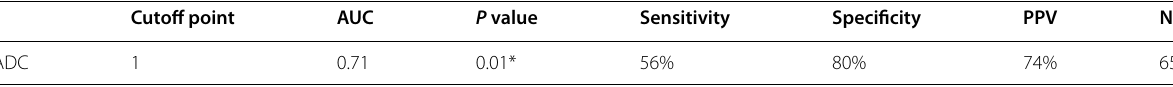
Table 5 Cutoff value, sensitivity and specificity of ADC as a predictor of neoplastic lesions Cutoff point